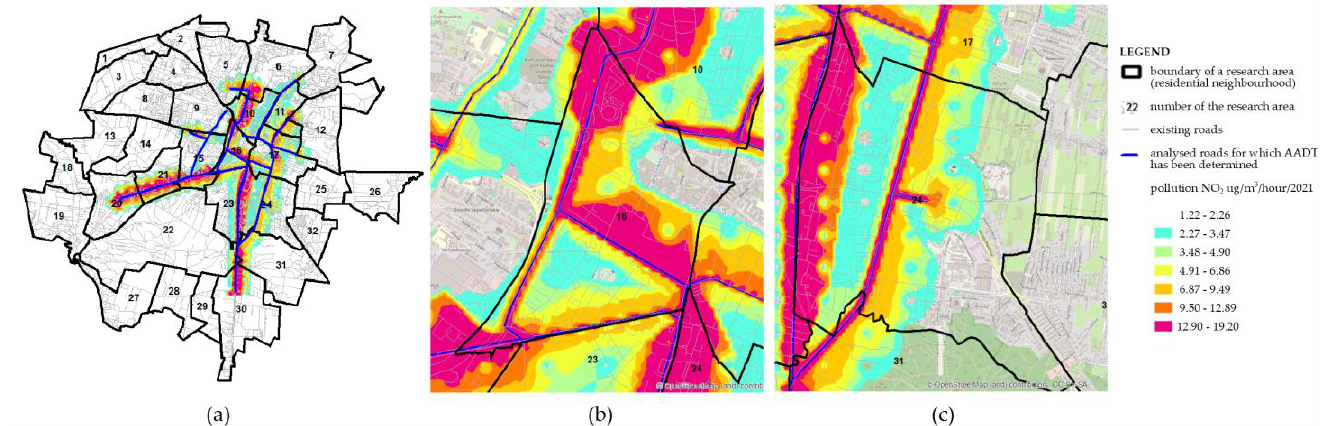
Figure 11. Map of predictions for NO 2 generated by the roads investigated in Kielce city in 2021; ( a ) situation for the 12 studied research areas; ( b ) situation for area no. 16; ( c ) situation for area no. 24. This was followed by the comparison of NO 2 concentrations measured at two air monitoring stations (placed within the boundaries of area no. 10) (Figure 12) with the data resulting from the prediction model calculated for linear sources (Figure 13). The data were read from two air monitoring stations and for two seasons, which correspond to gaseous pollutants [42,47]. The level of NO 2 pollution shown in Figure 12 is representative of the adopted survey periods. As can be seen, the levels of pollution with NO 2 for the two stations are similar. The average hourly level of NO 2 in the summer season (the level read on 23 June 2021) was 18.9 µ g/m 3 for station MS01 and 12.7 µ g/m 3 for